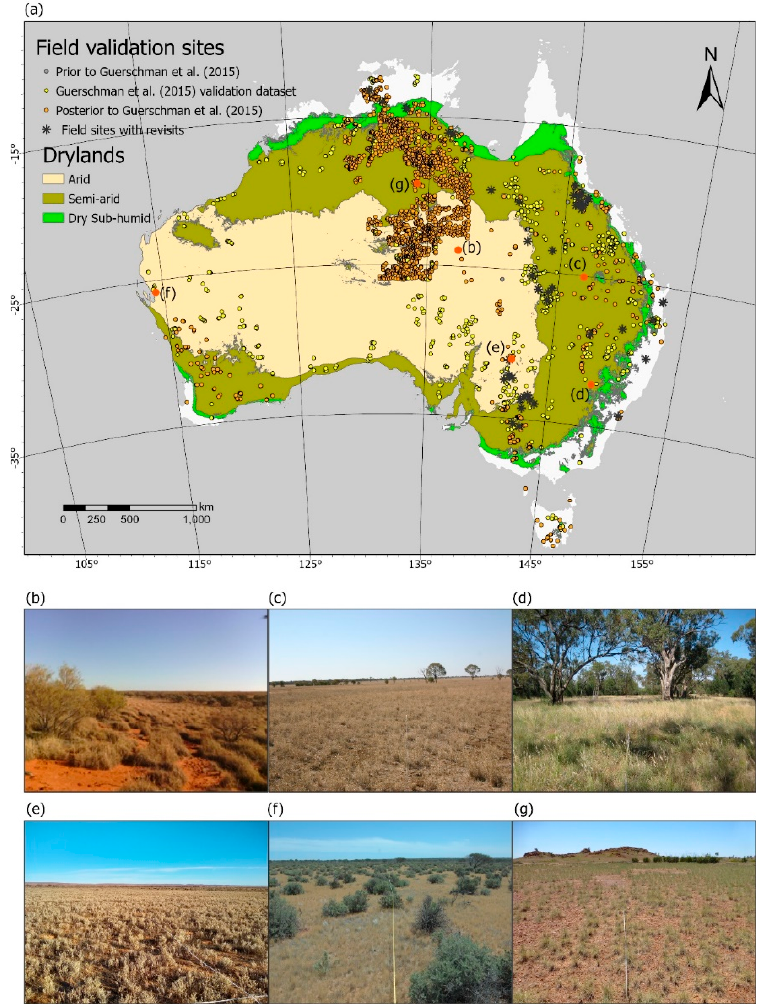
Figure 1. Vegetation in Australian drylands. ( a ) The location of field sample plots and drylands subdivisions across Australia. The dataset consists of 4243 field sites sampled following Muir et al. (2011); 162 were sampled previous to the dataset employed in Guerschman (1171 sites), and a further 2874 were sampled afterwards. Drylands were mapped according to the average aridity index for the period 1976–2005 (Harwood et al., 2019) after the following thresholds: 0.05 ≤ arid < 0.2 ≤ semi-arid < 0.5 ≤ dry sub-humid < 0.65. ( b – g ) Field photographs of select field sites ( b ) Hummock grassland on dune slope; ( c ) Tussock grassland on plain; ( d ) Grassy woodland near creek; ( e ) Chenopod shrubland on plain; ( f ) Open scrub on plain; ( g ) Hummock grassland on plain. Photographs ( a – d ) and ( f , g ) were obtained from https://data.tern.org.au/rs/public/data/field_validation/sitedata/, accessed on 15 September 2022, ( e ) was captured by the authors in May